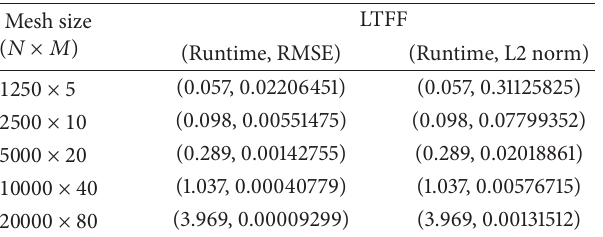
Table 5: Comparison of RMSE and L2 norm with LTFF method in the